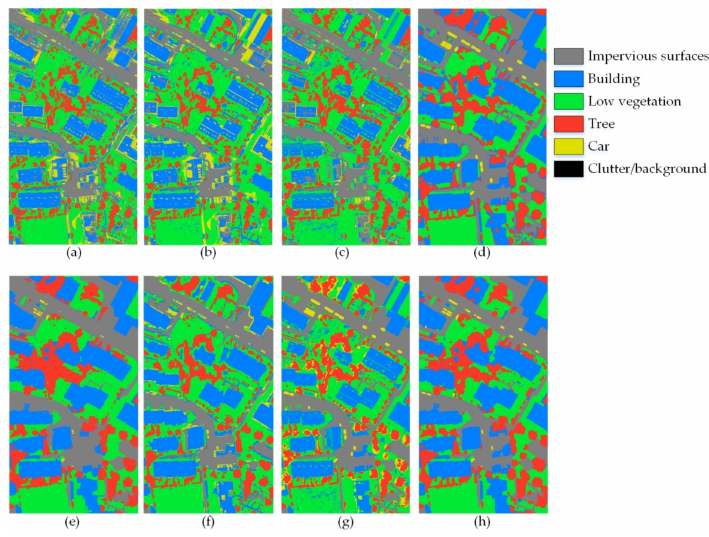
Figure 5. Comparison of the classification result images of eight methods for study image 1. ( a ) k -NN; ( b ) MLP; ( c ) SVM; ( d ) Pixel-based CNN; ( e ) CNN + CRF; ( f ) CNN fusion MLP; ( g ) CNN features + MLP; ( h )